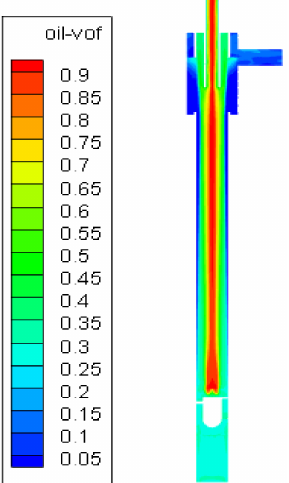
Figure 14. Distribution cloud of oil concentration inside the separator.